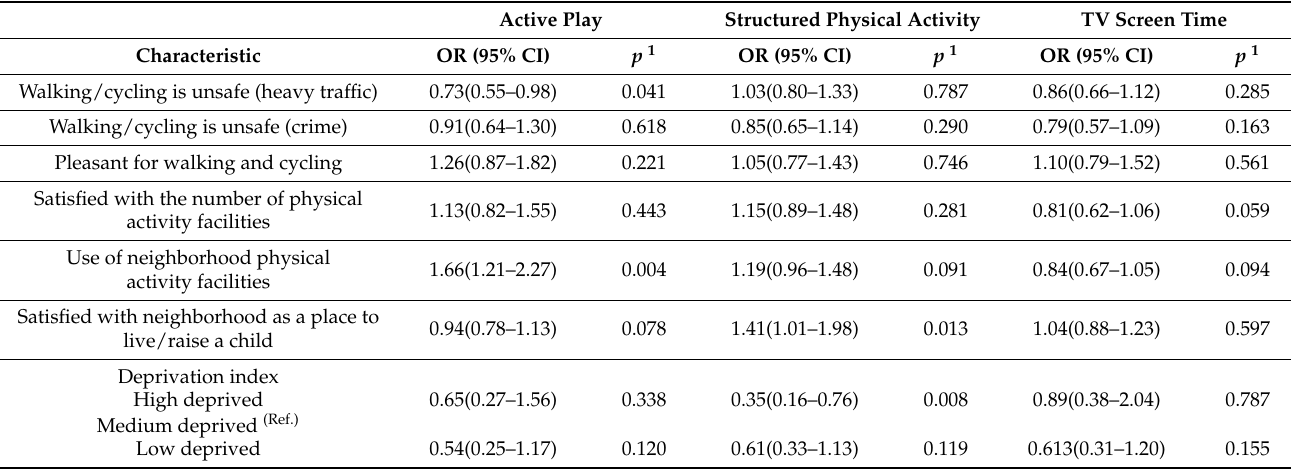
Table 5. Associations between parents’ perception of their neighbourhood, deprivation index, and children’s active play, structured physical activity and TV screen